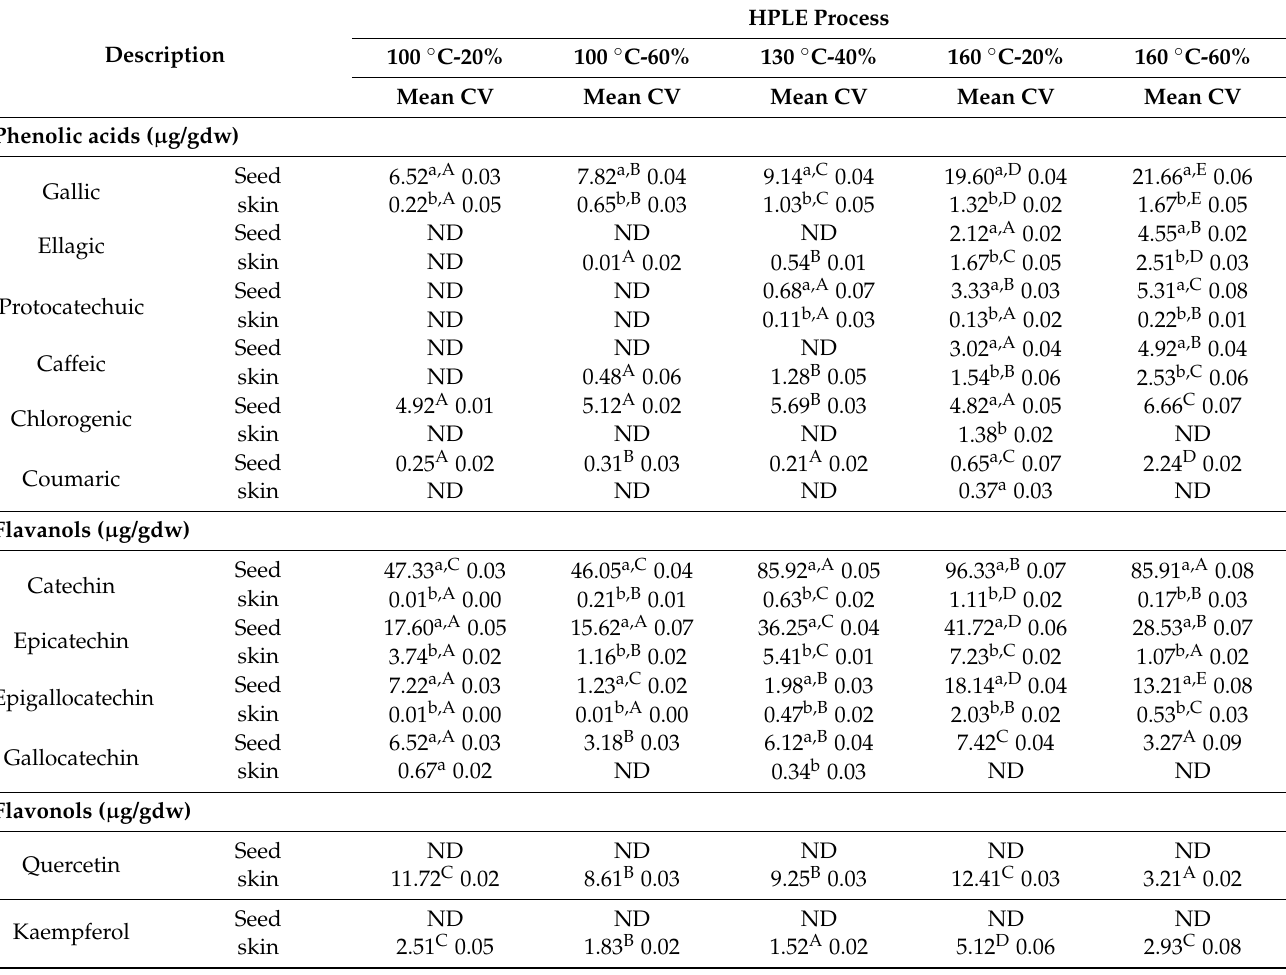
Table 2. Chemical characterization of extracts obtained from Negra Criolla seed and skins using ethanol at high temperatures.